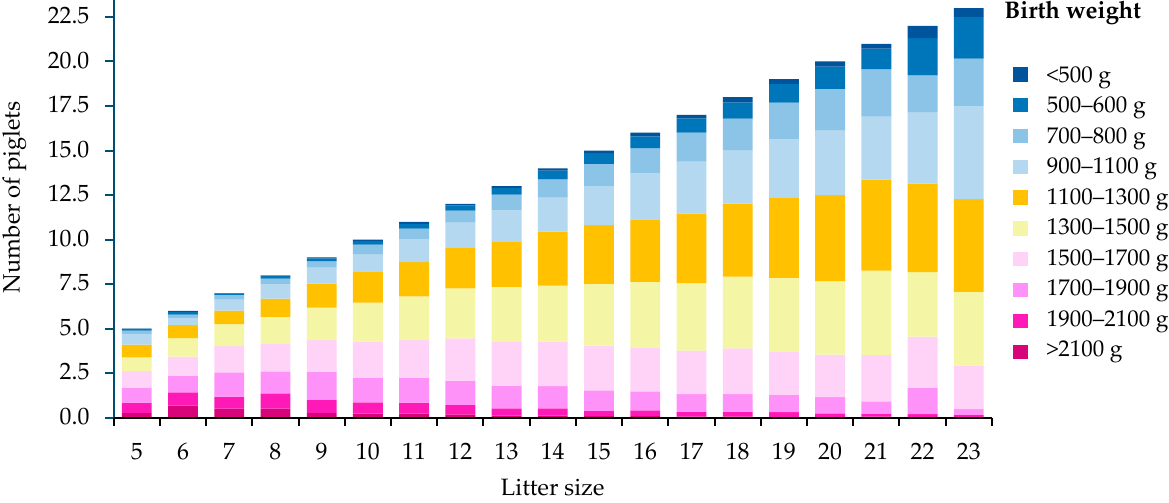
Figure 1. Effect of litter size on birth-weight distribution. The data were collected at Schothorst Feed Research B.V. (Lelystad, The Netherlands) from 2011 to 2019, based on 97,552 piglets born alive from 7888